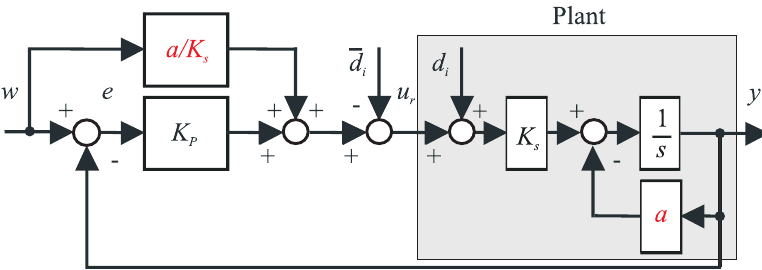
Figure 1. Controller design with compensation of an input disturbance d i = d + d m merging effect of an external disturbance d and of a modeling disturbance d m due to model uncertainty.